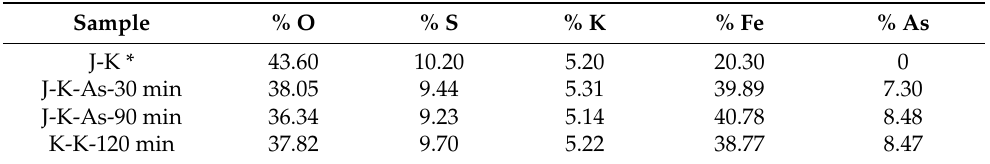
Table 3. SEM-EDS analysis performed on synthesized potassium jarosite and that with As(V) adsorp- tion at different reaction times (30, 90, and 120 min).